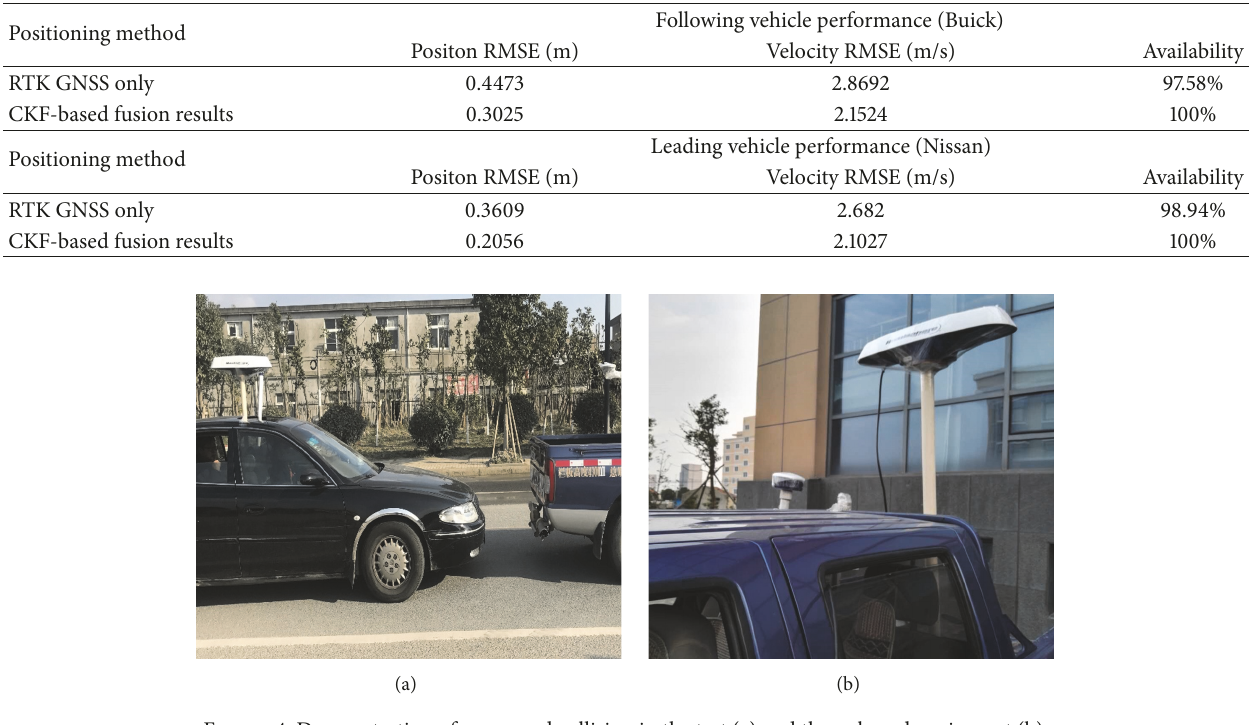
Figure 4: Demonstration of a rear-end collision in the test (a) and the onboard equipment